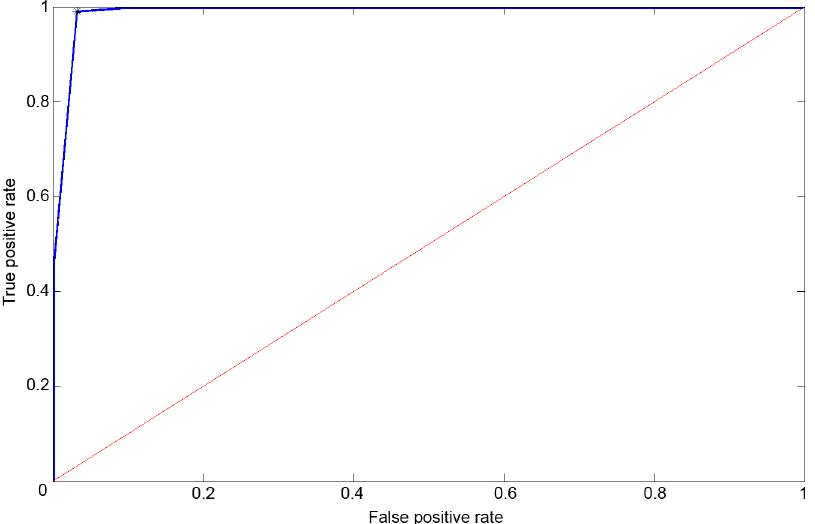
Fig 2. Receiver operating characteristic plot of the gbm classifications: The features of the ACG data for 97 patients with asymptomatic atrial fibrillation (40 female, 57 male, age 66.26 +- 6.54 years) were combined using a gradient boosting machine to classify if a patient has hypertension (positive result of the test) or if a patient does not have hypertension (negative result of the test). The AUC was 0.958 (sensitivity 0.99, specificity 0.968).